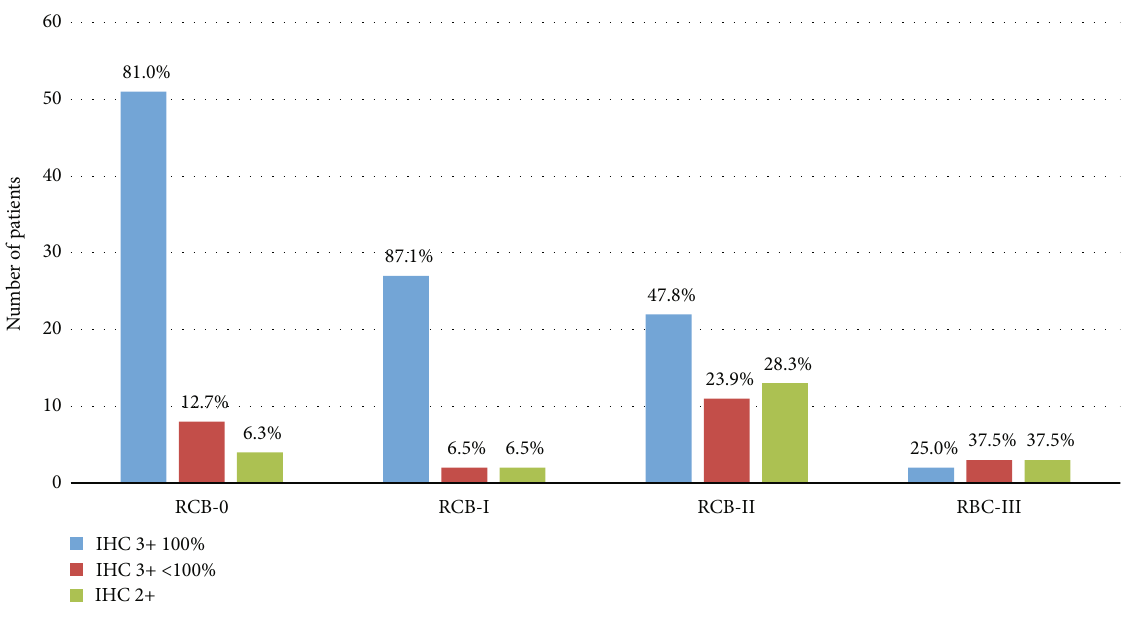
Figure 2: HER2 IHC staining characteristics by post-neoadjuvant residual cancer burden